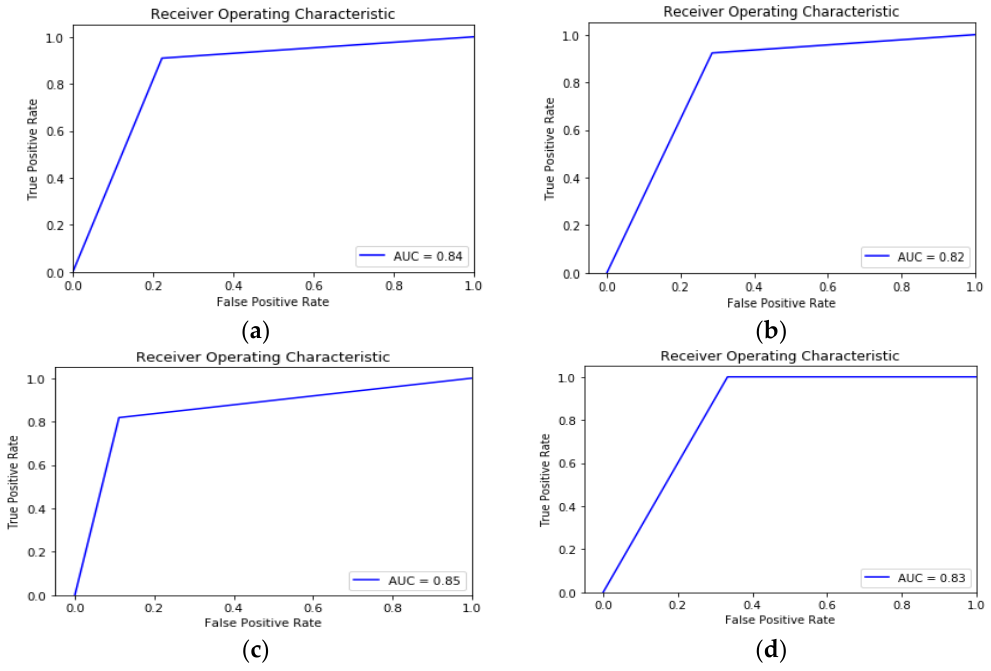
Figure 5. Accuracy, precision, recall e f1-score (test set); ( a ) HSV with principal component analysis (PCA), ( b ) HSV without PCA, ( c ) LAB with PCA, ( d ) LAB without PCA.